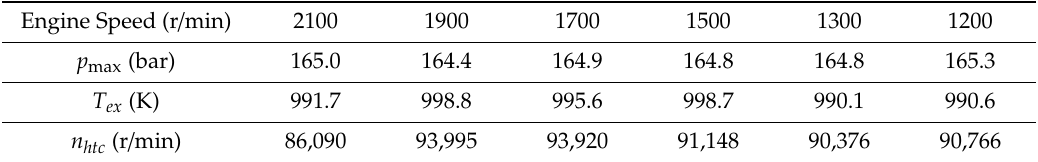
Table 2. Boundaries after